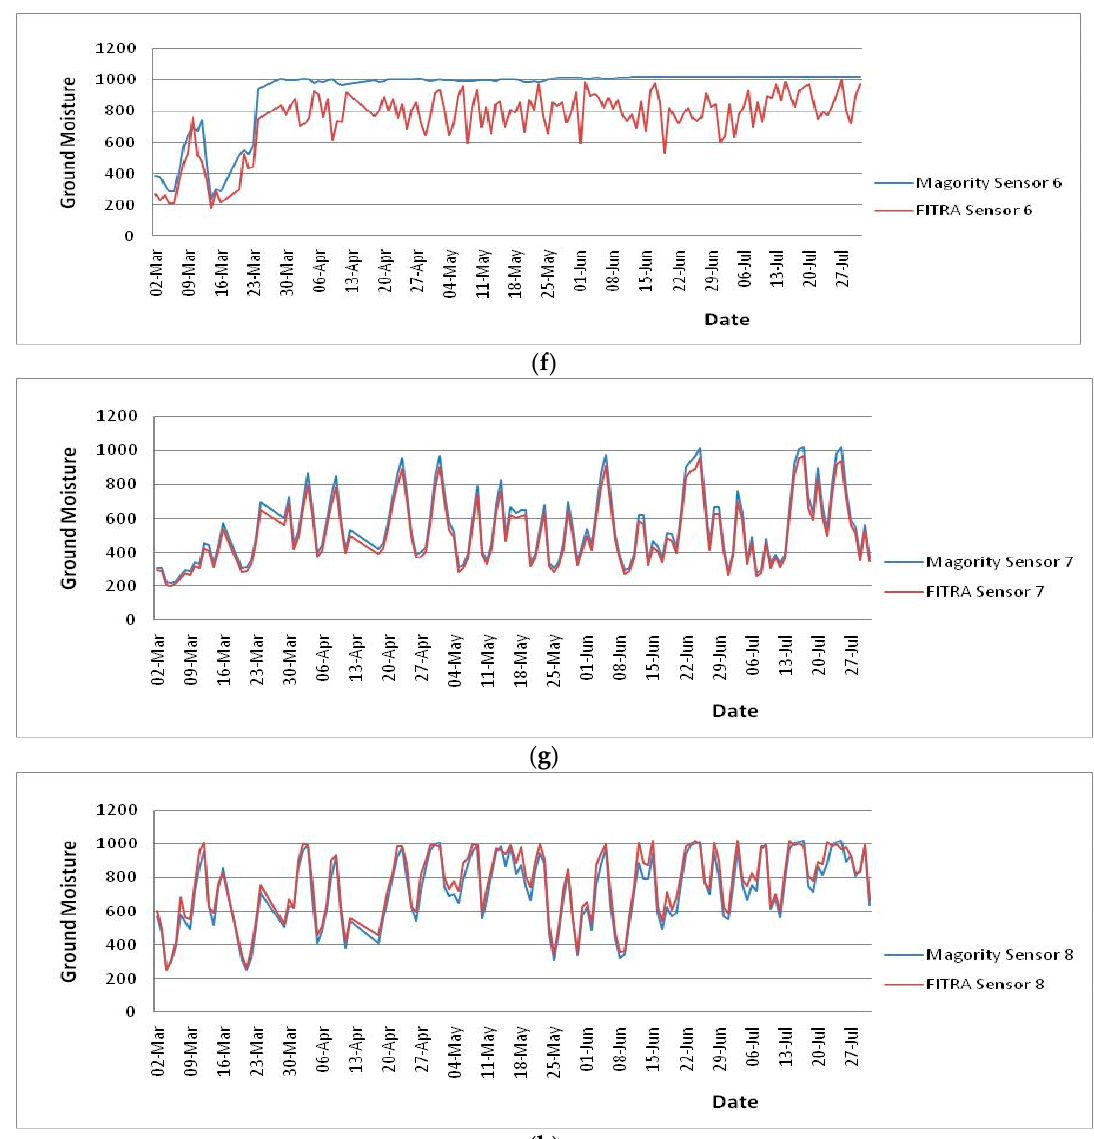
Figure 8. ( a ) Mean value per day of ground moisture sensor 1 for the two scenarios; ( b ) Mean value per day of ground moisture sensor 2 for the two scenarios; ( c ) Mean value per day of ground moisture sensor 3 for the two scenarios; ( d ) Mean value per day of ground moisture sensor 4 for the two scenarios; ( e ) Mean value per day of ground moisture sensor 5 for the two scenarios; ( f ) Mean value per day of ground moisture sensor 6 for the two scenarios; ( g ) Mean value per day of ground moisture sensor 7 for the two scenarios; ( h ) Mean value per day of ground moisture sensor 8 for the two scenarios.